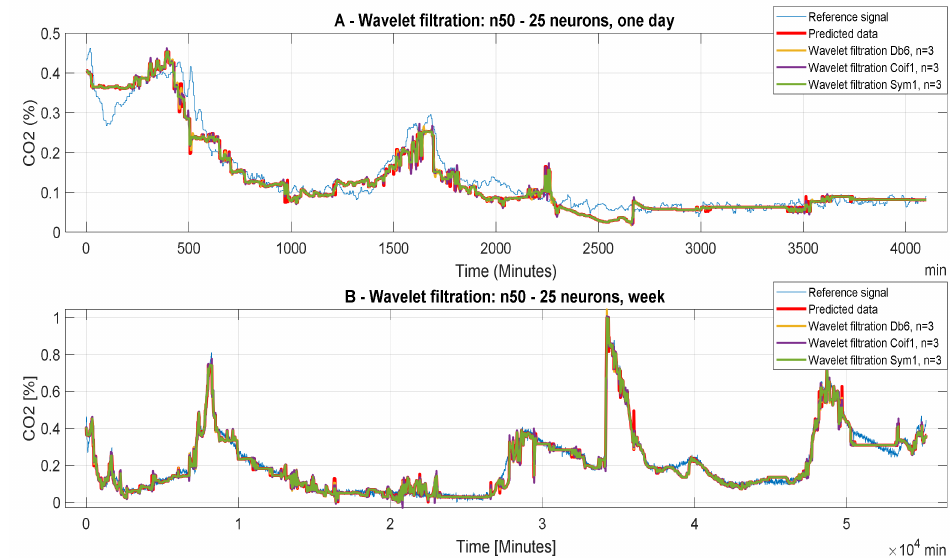
Figure 15. The dependency of CO 2 concentration on the time period for the neural network with 400 neurons.